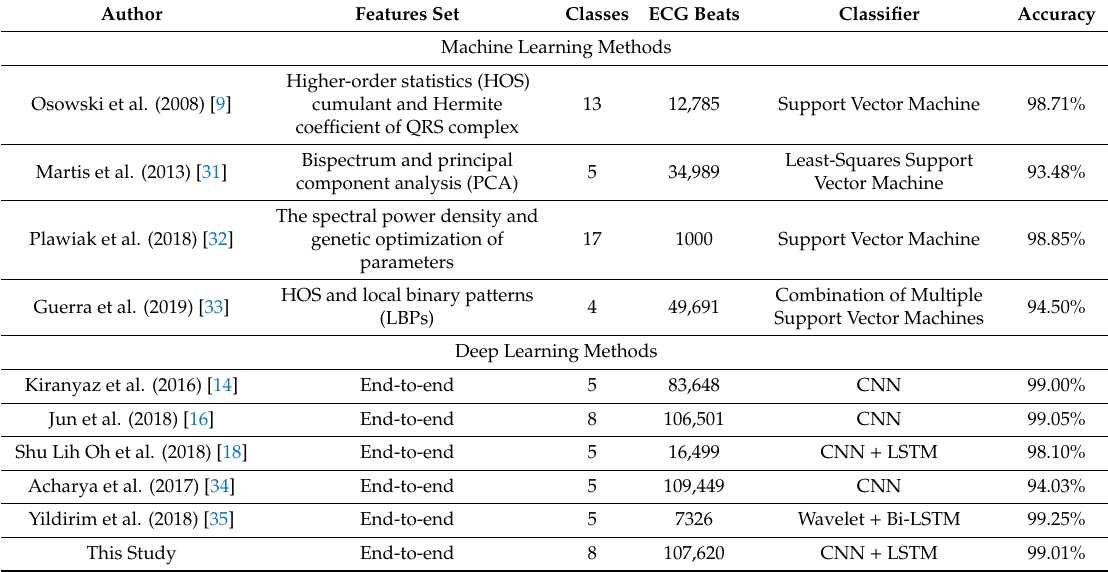
Table 8. Correlational studies of ECG